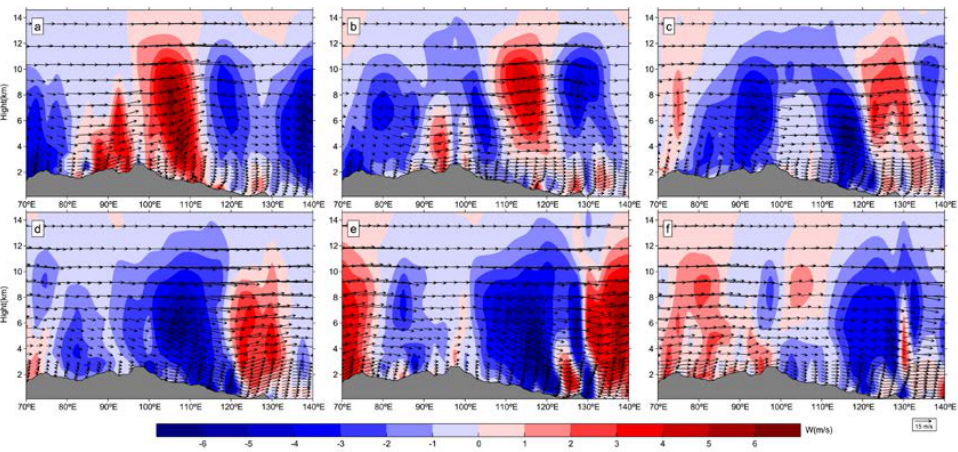
Figure 8. Vertical profile of the whole-layer MERRA-2 wind field on 2–7 May (shaded area represents the W wind; to show more clearly, W = −30 W in the figure; blue indicates vertical downward movement and red indicates upward vertical movement, sub-graph (a) to (f) respectively describe the wind field on 2–7 May 2017).